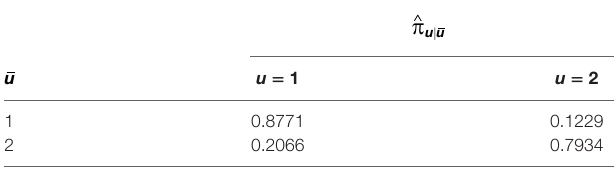
Table 8 | Estimates of the transition probabilities between non-conception (1) and conception (2) states referred to the LM chain of the estimated